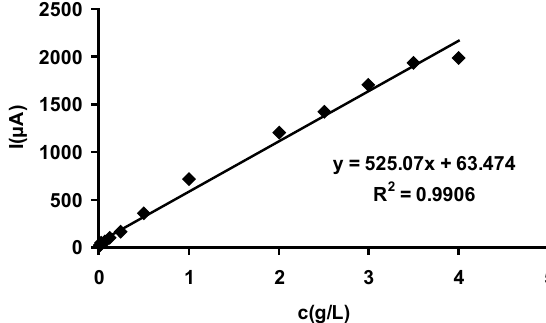
Figure 6: The calibration graph, as current intensity versus sulfite concentration dependence, obtained with the Pt strip electrode Radelkis